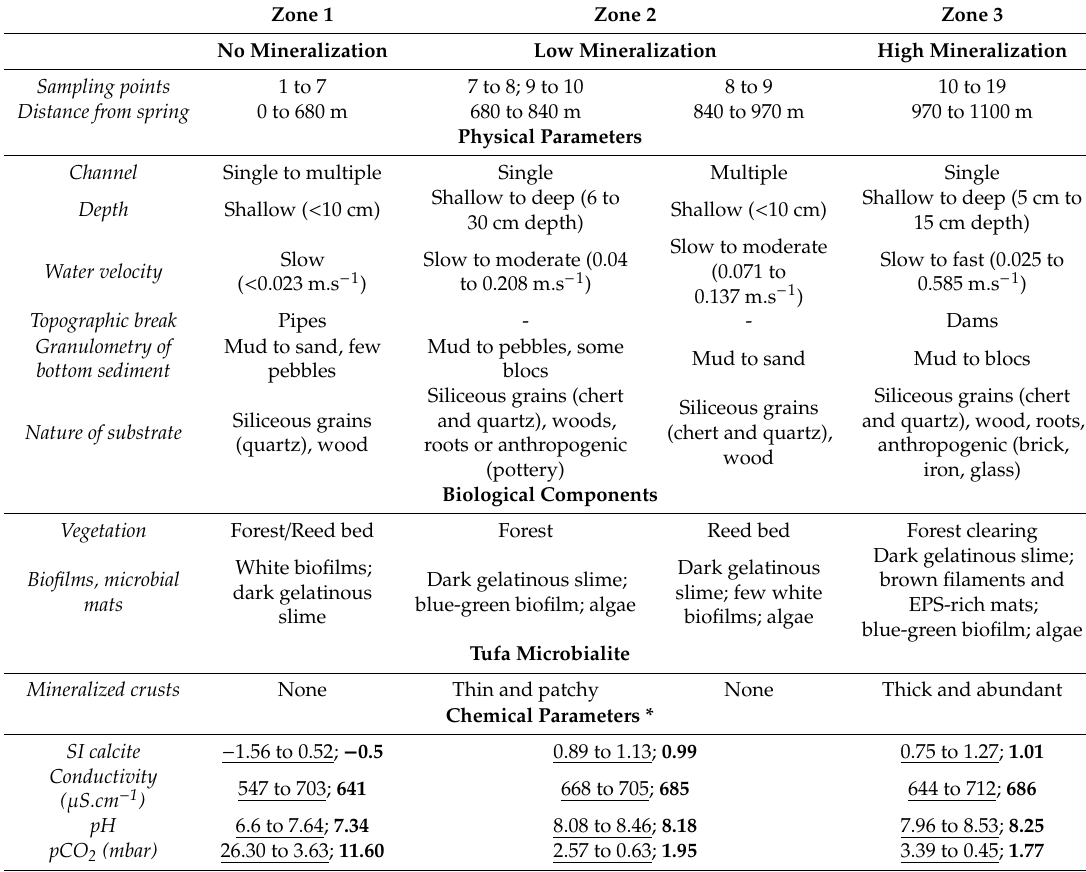
Table 1. Major characteristics of three zones of the stream; see detailed analyzes in the text below for biological